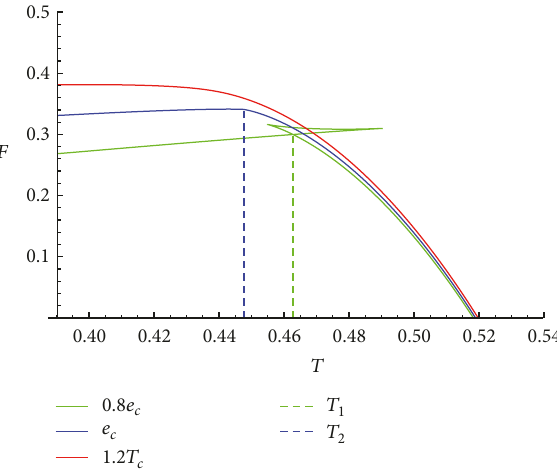
Figure 4: The 𝐹 - 𝑇 relation for different 𝑒 with 𝑞 = 0.05